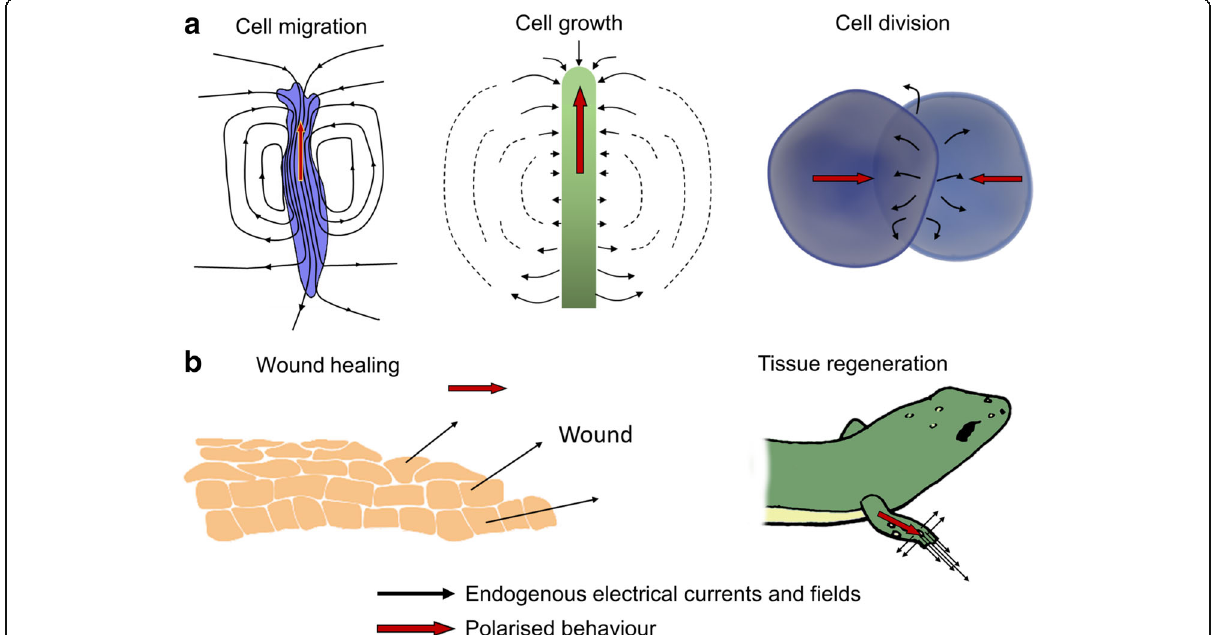
Fig. 3 Different biological functions can be triggered by the application of electric fields and these include actuating cell movement, modulating the cell cycle which benefits wound healing and tissue regeneration. Currents can polarise a) single cells and b) tissues. Black arrows indicate the direction of the electrical currents whereas red arrows indicate the direction of the resulting polarised behaviour (Chang and Minc